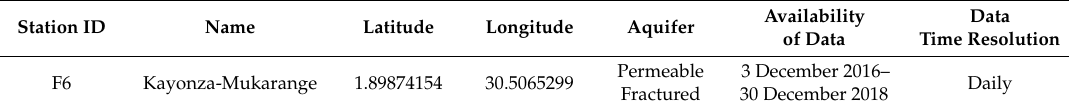
Table 1. Summary of the selected monitoring well and its main features.